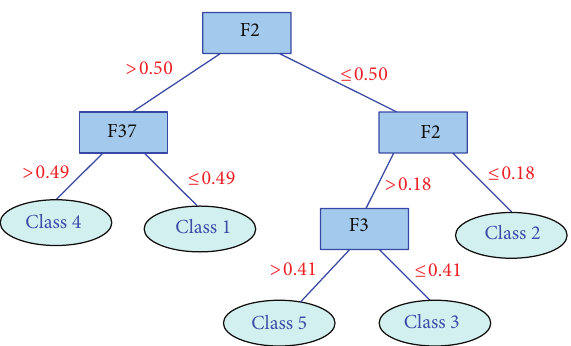
Figure 17: Decision tree trained on the features selected with fuzzy rough sets.